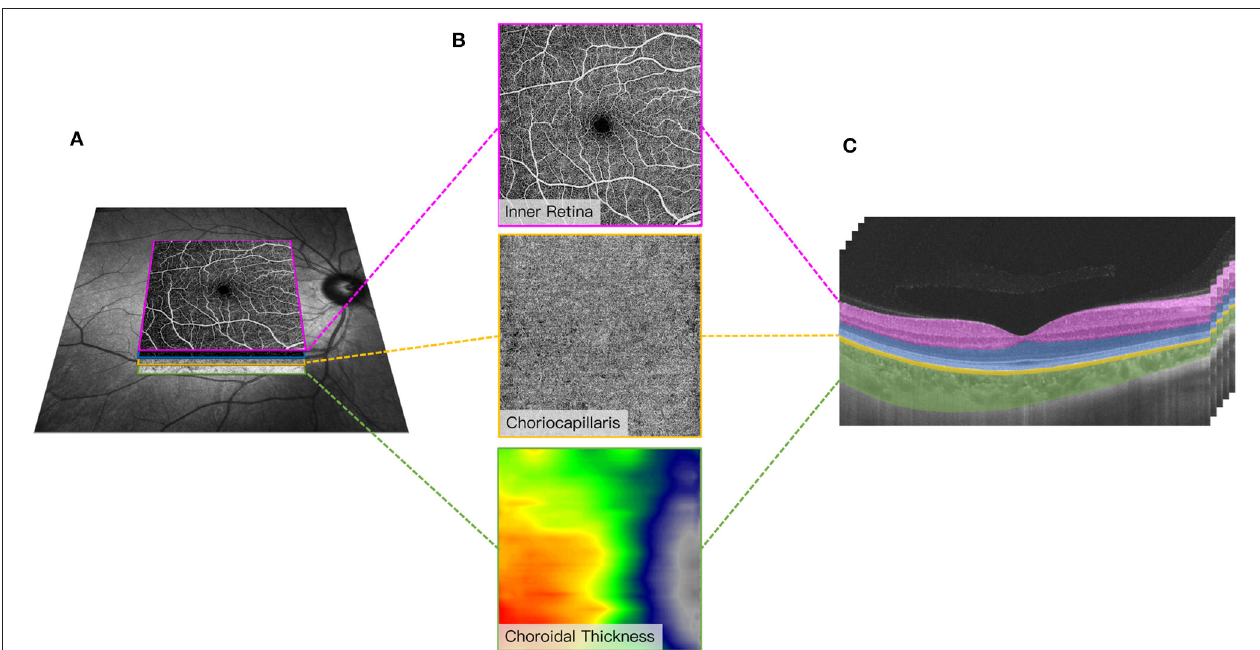
FIGURE 2 | Representative 6 × 6mm image of the macular microvasculature, choriocapillaris, and choroid centered on the fovea (A) . En face angiograms of the inner retina and choriocapillaris were generated by automatic segmentation in the OCT tool. A graphical representation of the choroidal thickness was shown to indicate the thickness. Warm colors indicate a thick choroidal structure while cold colors indicate a thin choroidal structure (B). Segmentation of the inner retinal microvasculature, choriocapillaris, and choroidal thickness (C) . The inner retinal microvasculature was defined as microvessels found 5 µ m above the inner limiting membrane (ILM) to 25 µ m below the lower border of the inner nuclear layer (INL). The choriocapillaris was defined as the microvasculature from the basal border of the retinal pigment epithelium – Bruch’s membrane complex to 20 µ m below it. Choroidal thickness was measured from the base of the RPE – Bruch membrane to the choroidoscleral